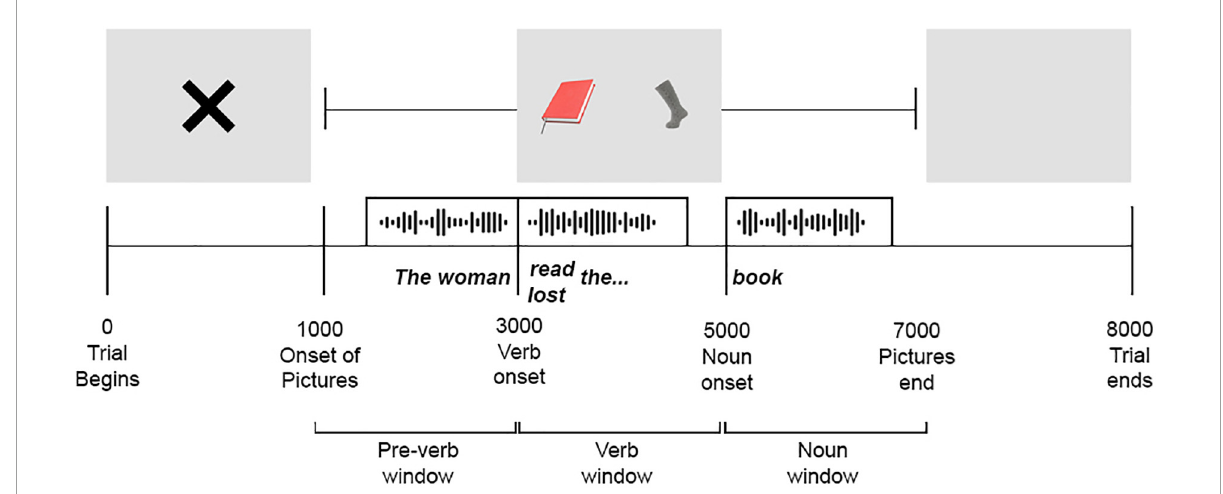
FIGURE1 Example of an experimental trial. The image used a creative commons zero (cc0) license and it is the image of public domain.